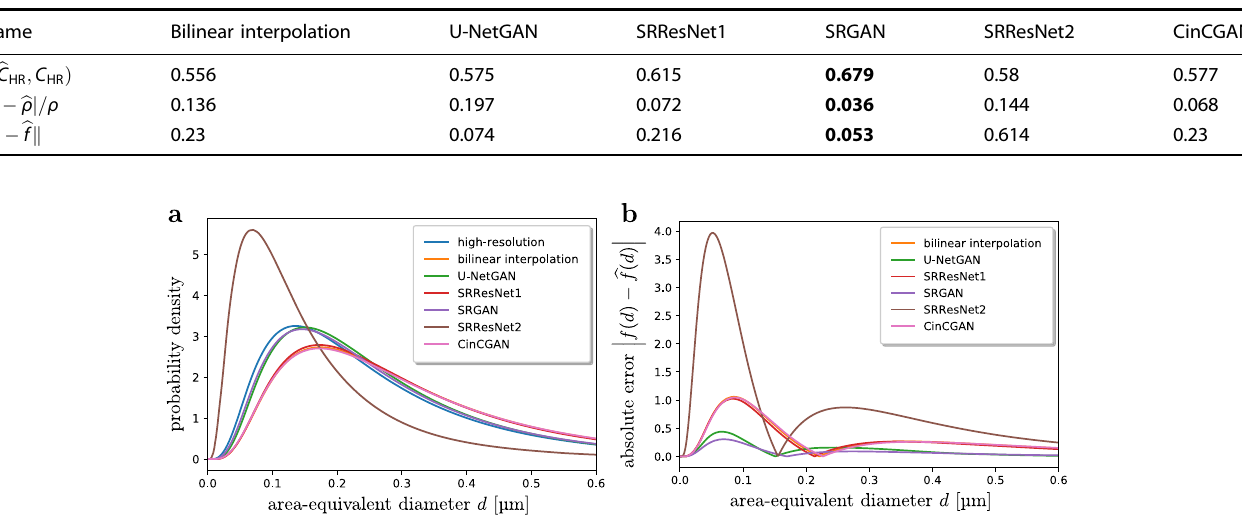
Fig. 5 Distribution of crack sizes. Probability densities of area-equivalent diameters of cracks computed from high-resolution, upsampled low-resolution and super-resolved image data ( a ), and point-wise absolute errors with respect to the probability density f computed from high-resolution image data ( b ).